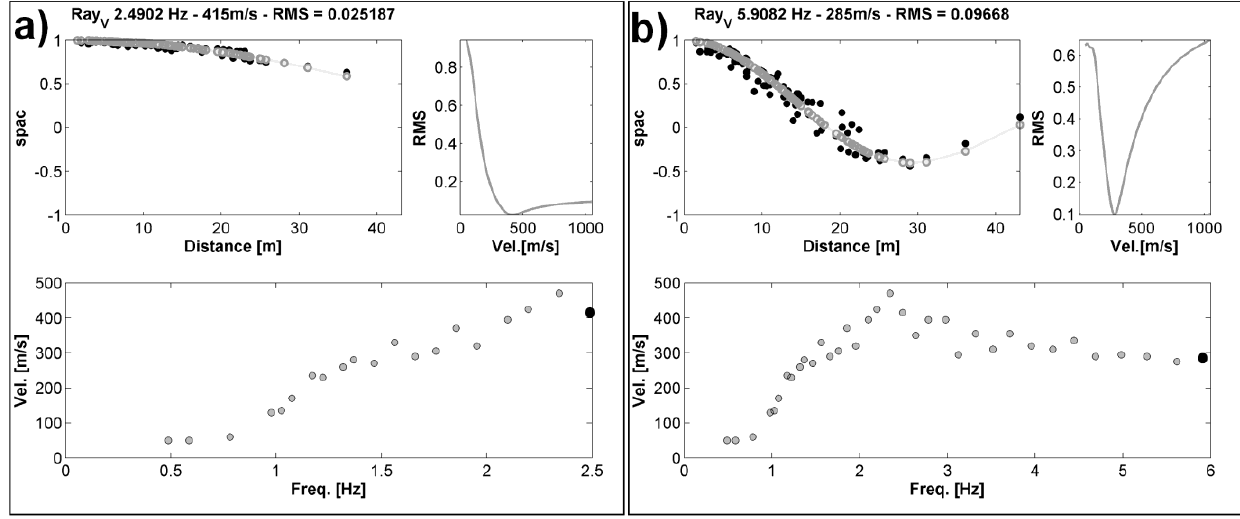
Figure 7. Real-time fitting procedure for Rayleigh-wave velocity estimation. (a) Analysis for the frequency 2.49 Hz. In the upper-right panel is shown the comparison between the observed spatial correlation function ( black dots ) and the theoretical Bessel function values for the best-fit velocities ( gray dots and line ). In the upper-left panel is shown the RMS for the tested velocities. In the lower panels are shown the evolutionary, real-time dispersion curve estimations, where the Rayleigh-wave velocities for the actual ( black dot ) and previous ( gray dots ) analyzed frequencies are shown. (b) same as (a) but for the frequency 5.9